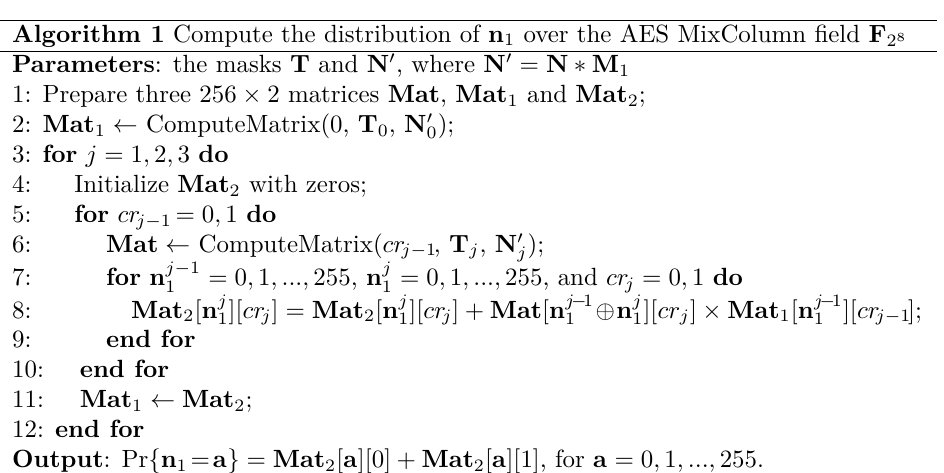
Algorithm 1 Compute the distribution of n 1 over the AES MixColumn field F